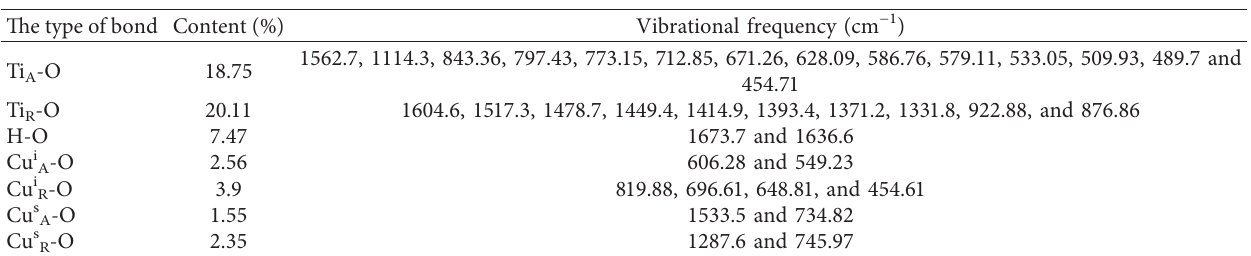
° C). (a) 400cm − 1 ∼ 1000 cm − 1 ; (b) 2 samples at calcination temperature (550 2 samples with the content and vibrational frequency of valence bonds.